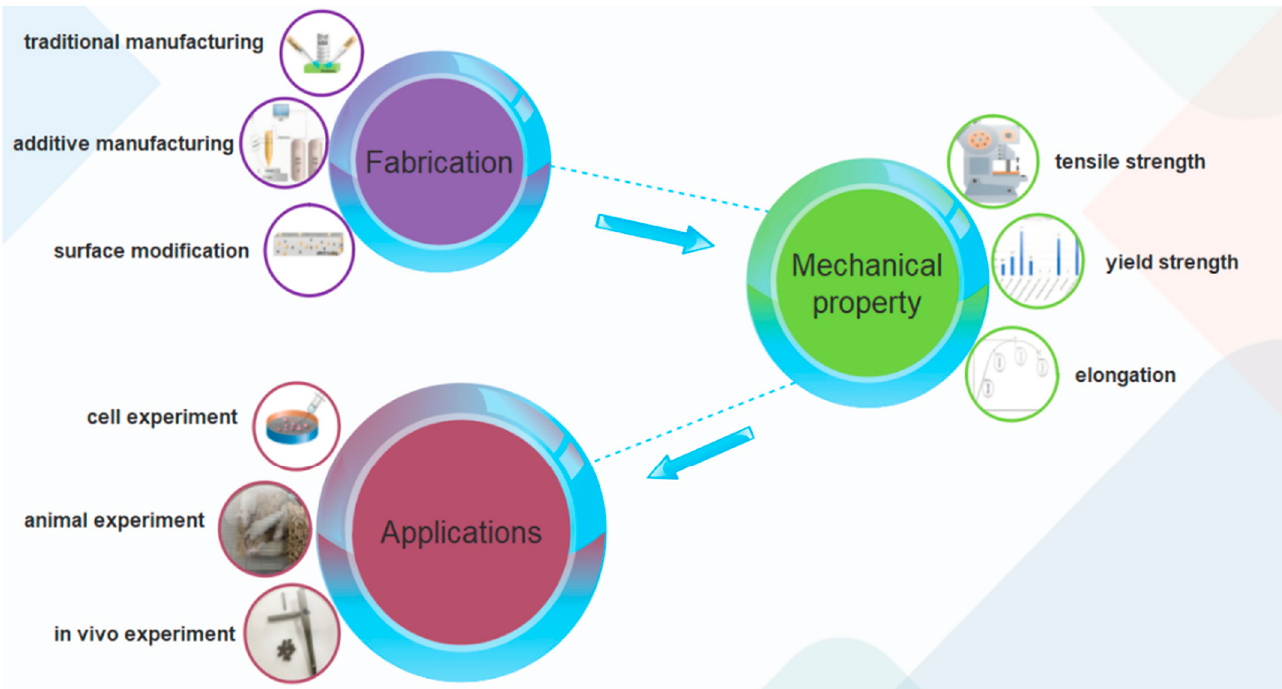
Figure 2. Fabrication, mechanical properties, and in vitro and in vivo biocompatibility of magnesium alloys in bone repair.